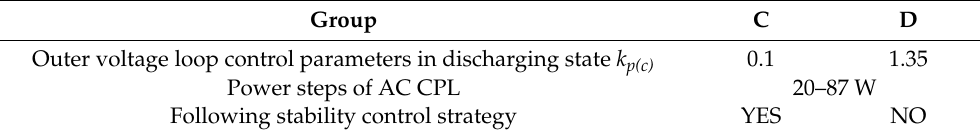
Table 5. Experimental platform parameters for groups C and D in the charging condition. Group Outer voltage loop control parameters in discharging state k